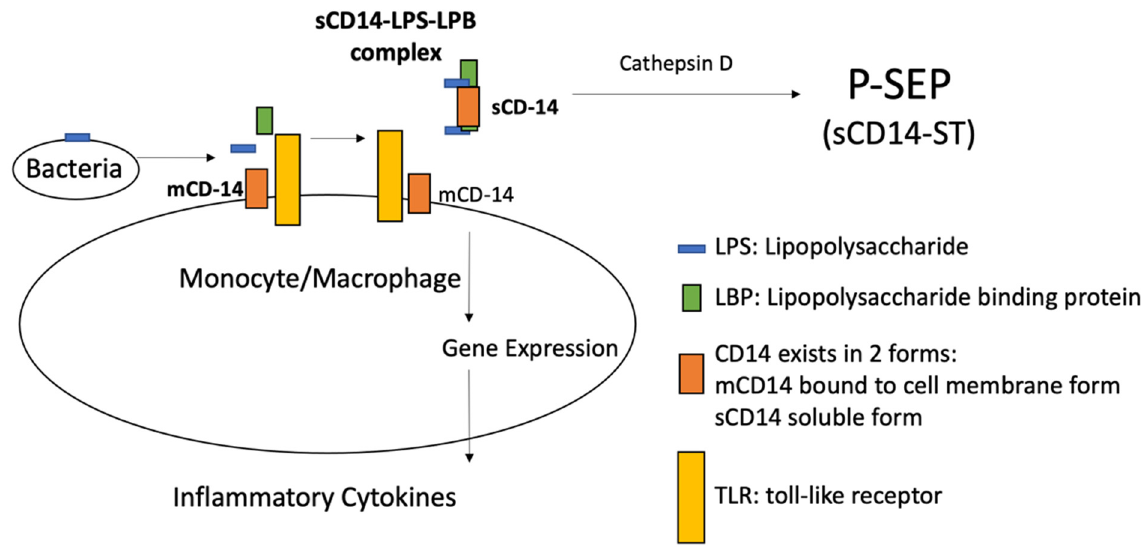
Figure 1. P-SEP is the 13 KDa N-terminal fragment of soluble form of CD14 (sCD14), cleaved by cathepsin D in plasma, and involved in activating the innate immune system.